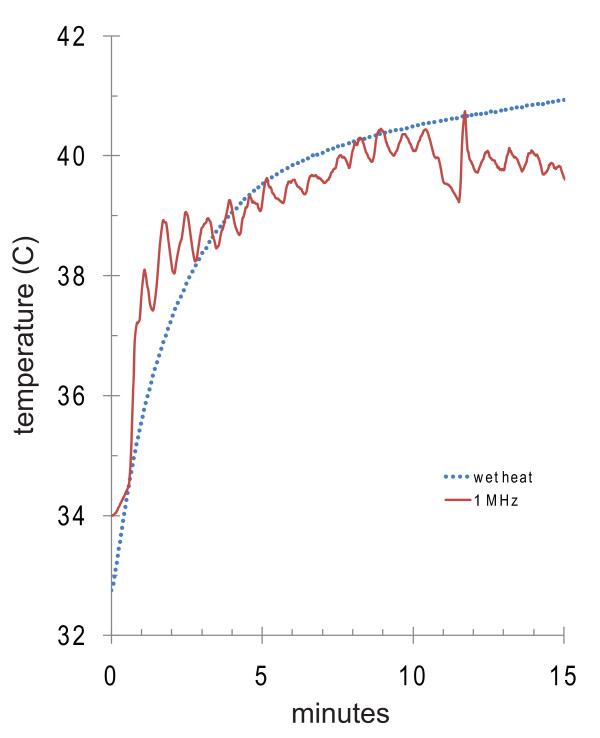
Representative temperature curves during ultrasound or wet heat. A thermal couple was inserted down the long axis of the testis and another was placed in the coupling medium. Coupling medium was re-circulated at 37°C during ultrasound treatments and at 45°C for the wet heat control. The rotation frequency of the transducer correlated with temperature fluctuations at the site of the thermal couple. The wet heat control yielded a testis temperature profile similar to an ultrasound treated testis.